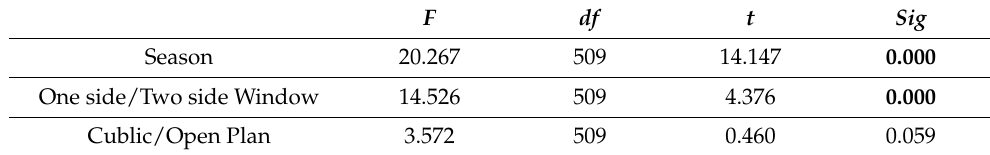
Table 8. t -test for DTR.